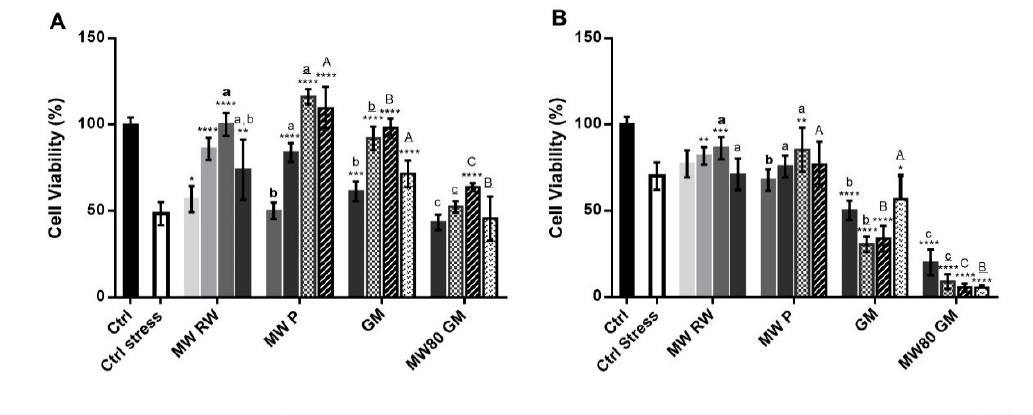
Figure 4. Pre-incubation of ( A ) HaCaT and ( B ) HFF with the extracts for 24 h – influence on cell viability upon TBHP-induced stress. The symbol * indicates significance relative to the control (* p -value ≤ 0.05, ** p -value ≤ 0.01, *** p -value ≤ 0.001, **** p -value ≤ 0.0001). The same concentrations of different extracts were compared (bold lowercase letters for 0.125 mg / mL; regular lowercase letters for 0.25 mg / mL; underlined lowercase letters for 0.5 mg / mL; regular uppercase letters for 1 mg / mL; underlined uppercase letters for 2 mg / mL). Statistically different results ( p -value ≤ 0.05) are identified with different letters. MW RW—MW-pretreated red wine lees extract; MW P—MW-pretreated Port wine lees extract; GM—grape marc conventional extract; MW80 GM—MW-pretreated grape marc extract (max. temp. 80 ◦ C).